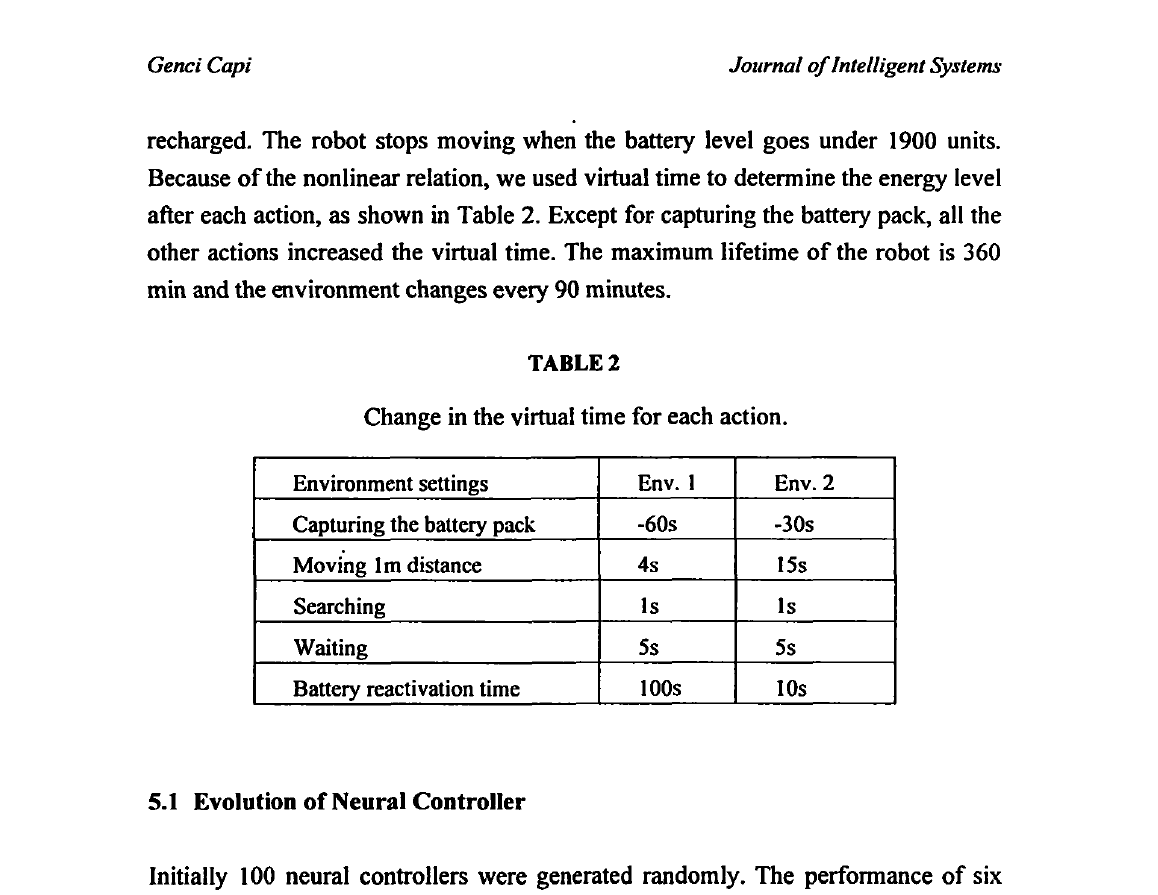
Change in the virtual time for each